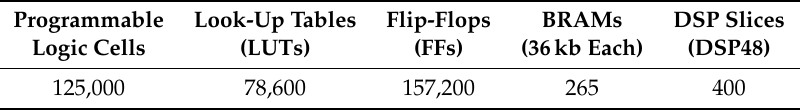
Table 1. Programmable logic resources of the Xilinx